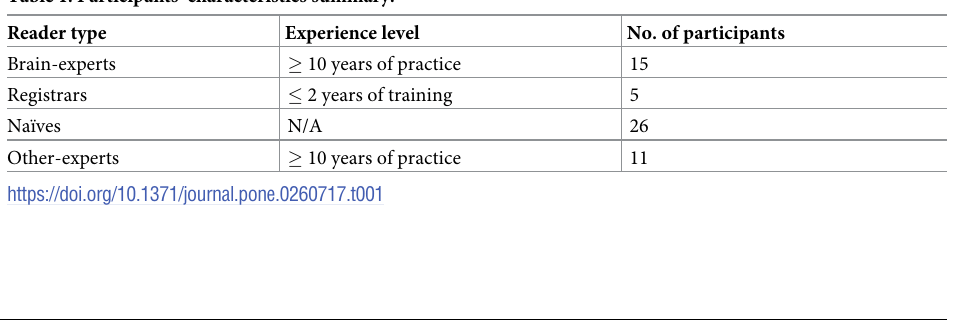
Table 1. Participants’ characteristics